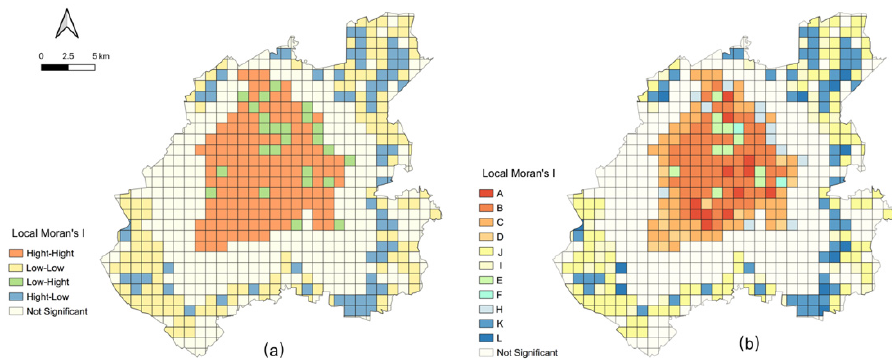
Figure 12. Local Moran’s I between service facility diversity ( a ) and population activity intensity ( b ). Table 2. Characteristics of the spatial match between service facility diversity and population activ- ity intensity.